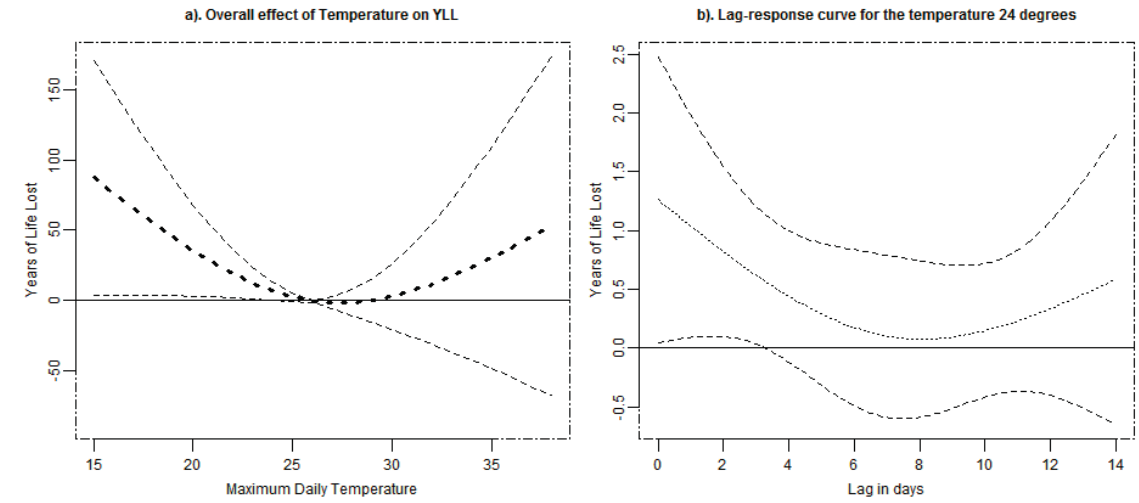
Figure 2. The overall effects of temperature on YLL ( a ) and the corresponding lag-response for temperature of 24 °C ( b ) due of all-cause mortality in NUHDSS with 95% confidence